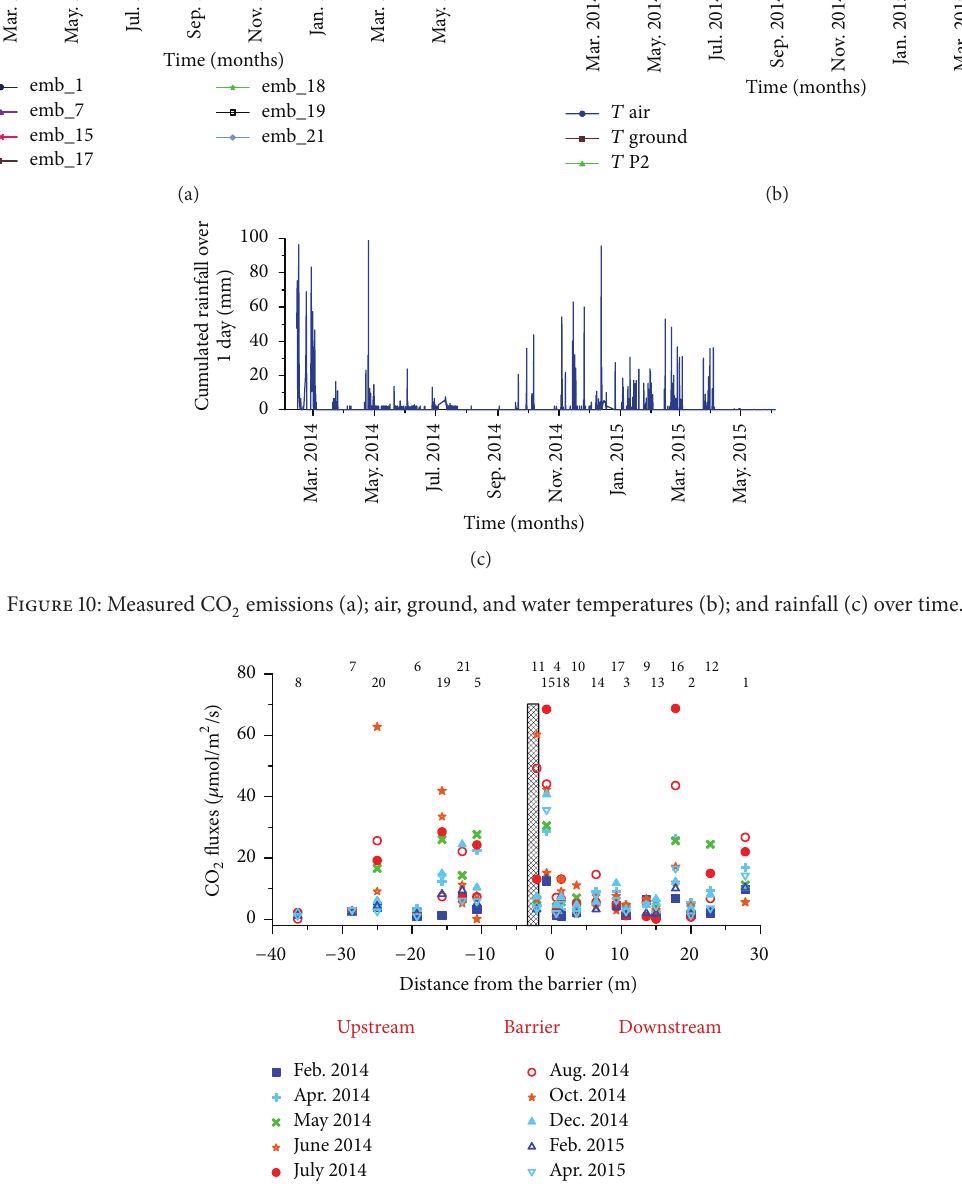
Figure 11: Measured CO 2 emissions (corrected from meteorological conditions) as a function of gas metering station location, for one year of